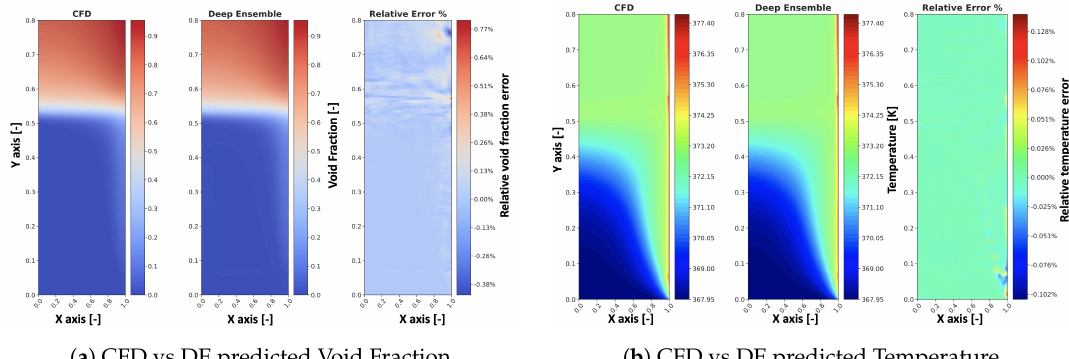
Figure A6. Interpolation dataset: Comparison of CFD and DE model prediction for q (cid:48)(cid:48) = 14,000 W/m 2 , u = 0.05 ms − 1 . It can be noted from Figure A6a that the DE model shows good performance when predicting the void fraction field with a maximum relative error of 0.77%. Similarly, the DE model shows an exceptional predicting capability for the temperature field with a maximum relative error of 0.13%. From this, it can be concluded the DE model shows almost an order of better accuracy when compared to the DNN model for the interpolation datasets.